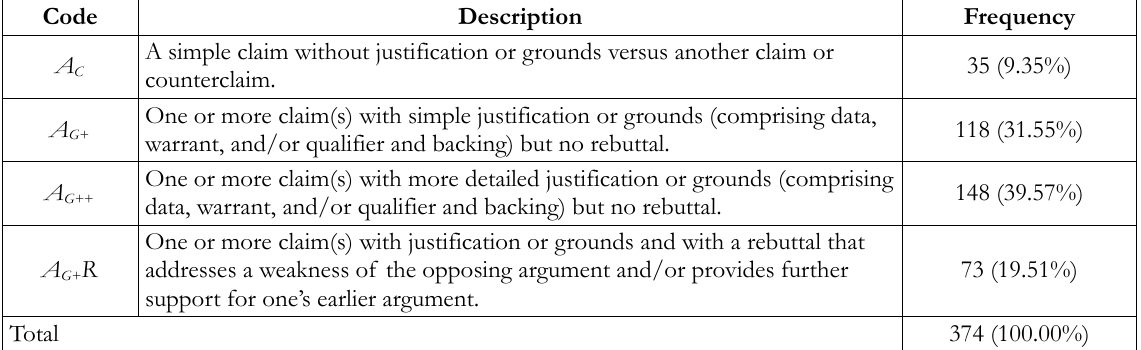
Table 7. Students’ scientific argumentation in the Socialization